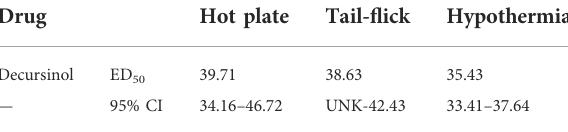
TABLE 1 Calculated ED 50 values (mg/kg) for the acute thermal antinociceptive and hypothermic effects of decursinol. ED 50 values were calculated from cumulative dose-response curves generated using non-linear regression analysis. Values shown